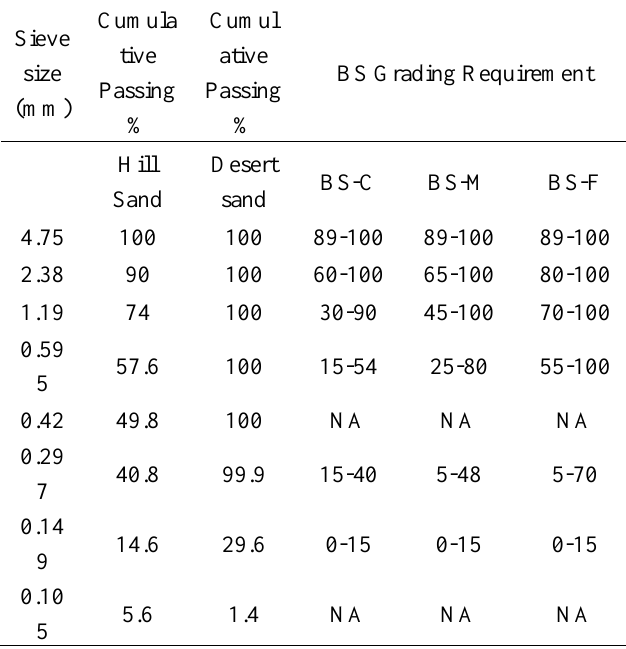
Fig. 4. Gradation of desert sand